Question: What does this figure show? Answer in one sentence.
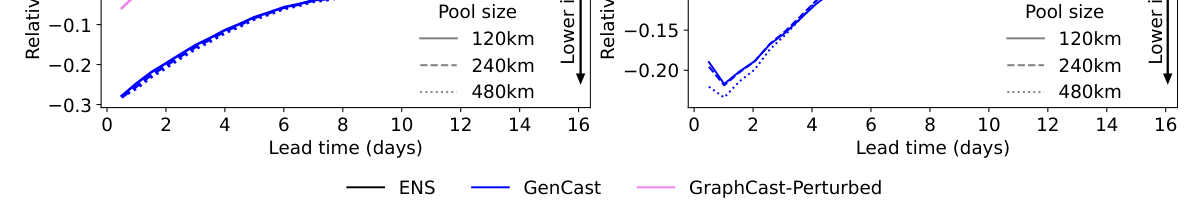
Answer: | Extreme weather, joint measures, and wind power. (a) Relative economic value (REV) for predictions of the exceedance of the 99.99th percentile for 2 m temperature, at lead times of 1, 5 and 7 days. (b) Relative economic value (REV) for predictions of the presence of a cyclone in any location at a given time, at lead times of 1, 3, and 5 days. (c) Relative CRPS of max-pooled 2m temperature, for different pooling region sizes. (d) Relative CRPS of the total wind power summed across wind farm locations in pooling regions of different sizes.